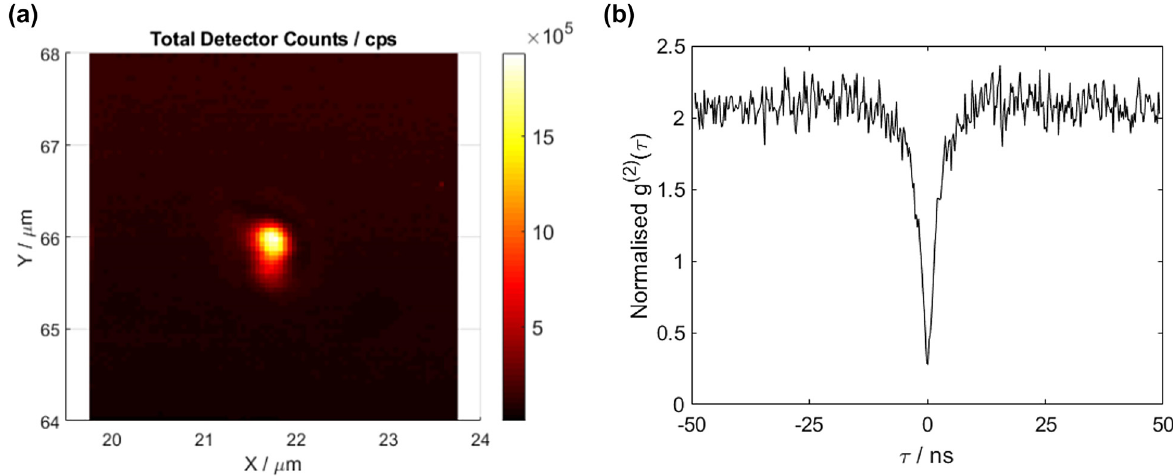
Figure 9: Photon characterization of quantum emission from hexagonal boron nitride (hBN). (a)Scannedintensitymapof emissionfrom hBNsampleataround570nm, excitedat 532nm.(b)The second-ordercorrelation g (2) ( τ ) function, the g (2) (0)<0.5 indicates single photon emission.